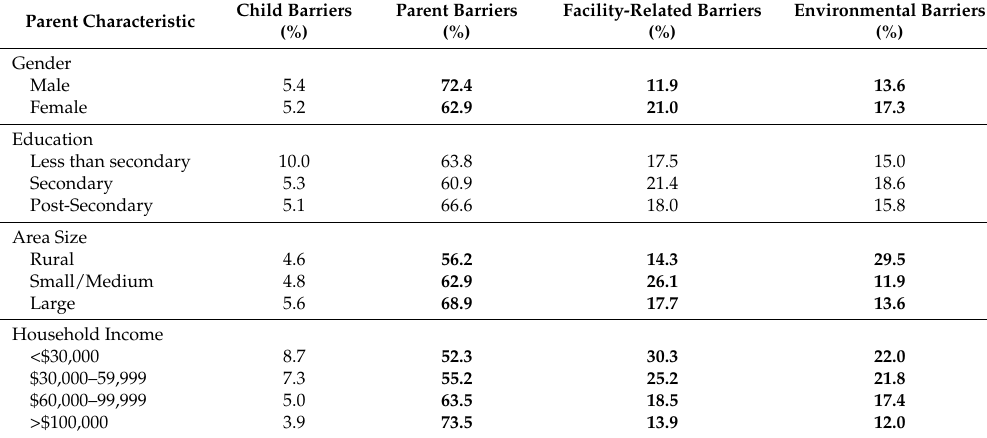
Table 5. Bivariate analysis of types of barriers by parent